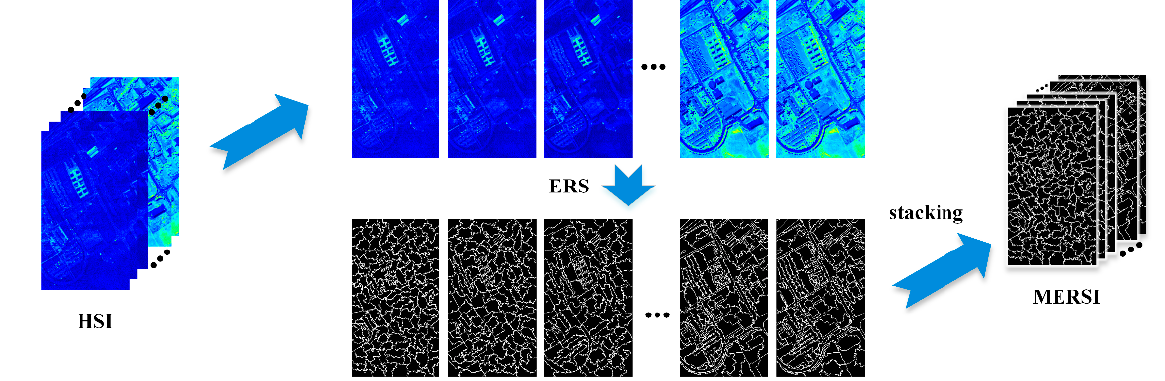
Figure 1. The process of the multi-spectral entropy rate superpixel segmentation.